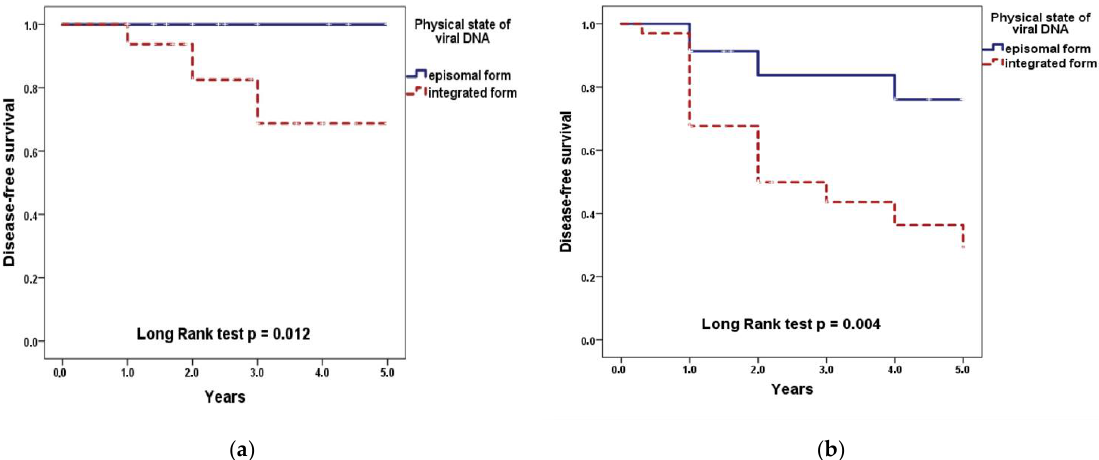
Figure 4. Disease free survival of CC patients with stages II ( a ) and III ( b ) depending on the physical state of the viral genome (episomal or integrated form).